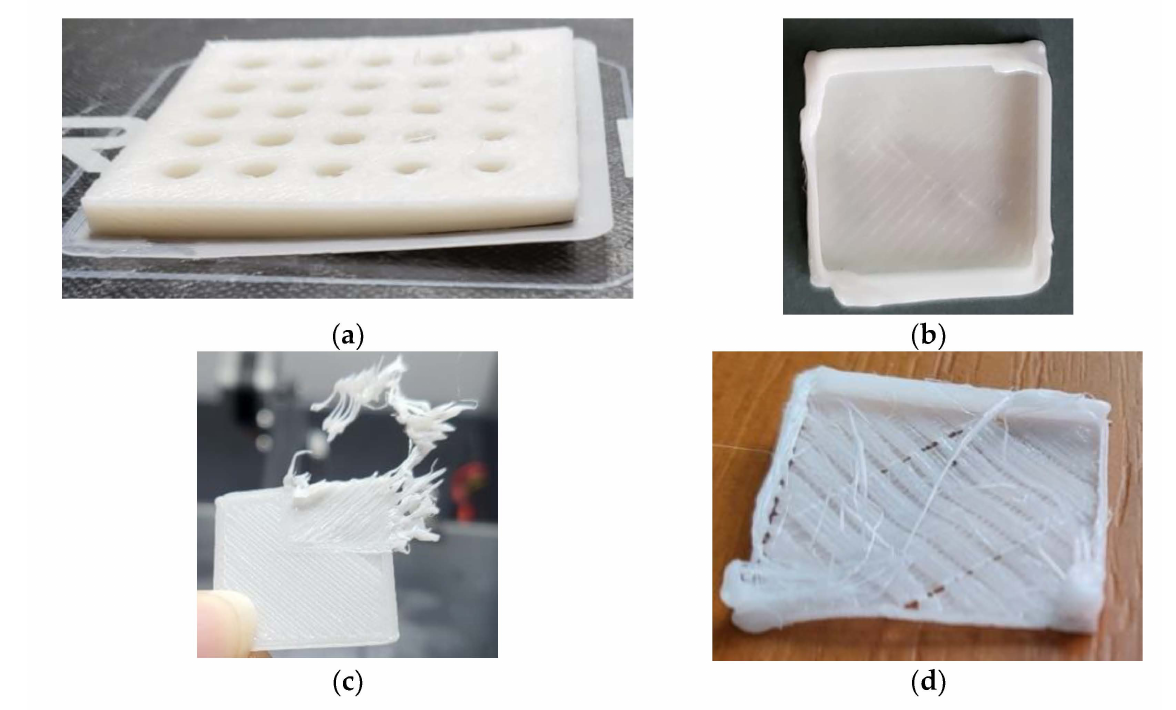
Figure 6. Optimization of 3DP process parameters. Defects: warpage ( a ); over-extrusion ( b ); sample adherence to the nozzle ( c ); under-extrusion, and sample adherence to the nozzle ( d